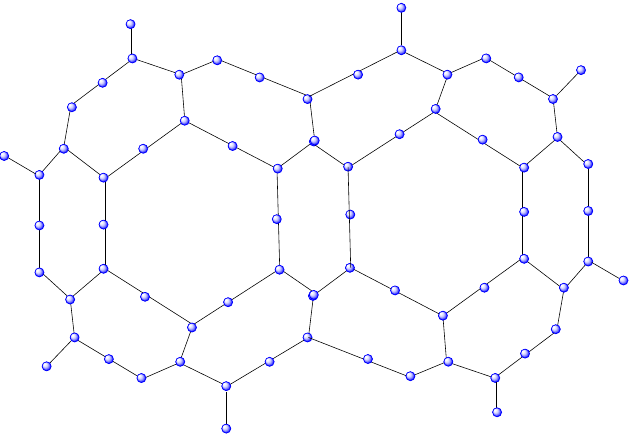
Figure 2. Layer structure of H 3 BO 3